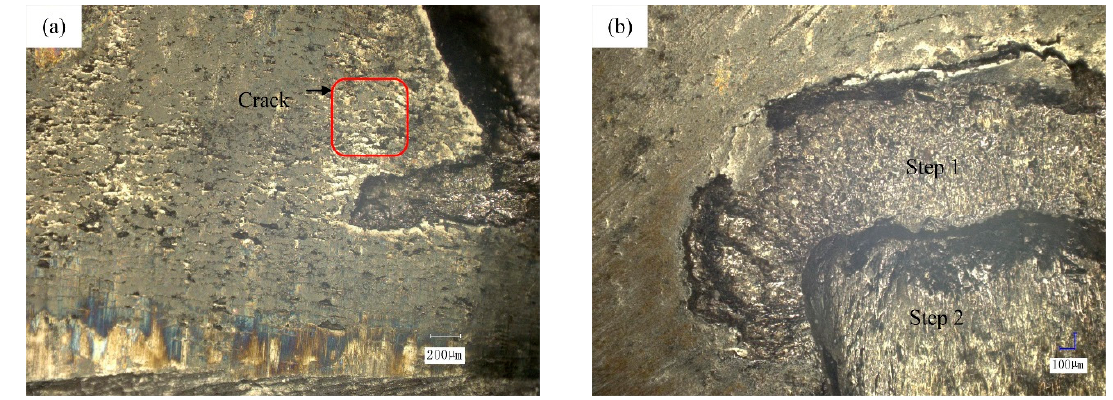
Figure 12. Morphology of the zones near the spalling on the gear 4 ‐ 2 tooth flank: ( a ) point (V5, H8) and ( b ) point (V5, H5).